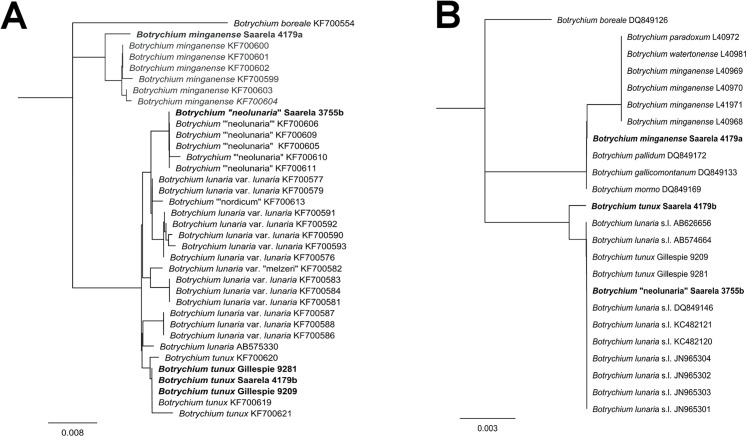
Neighbour-joining analyses (Jukes–Cantor substitution model) of new and previously published psbA-trnH and rbcL DNA sequences of Botrychium.Newly sequenced individuals are in boldface. (A) psbA-trnH dendrogram. (B) rbcL dendrogram.